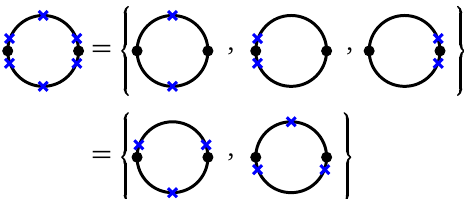
Figure 8: Intersections of the facets of the cosmological polytope P , associated to G the 1-loop 2-site graph, outside P . In this case, the list above exhausts all the zeroes G of the associated canonical form. The fact that the two set of graphs completely mark the graph implies the equivalence relation W ( G ) + W ( g 1 ) + W ( g 2 ) ∼ W ( g a ) + W ( g b ) among the hyperplanes identified by the